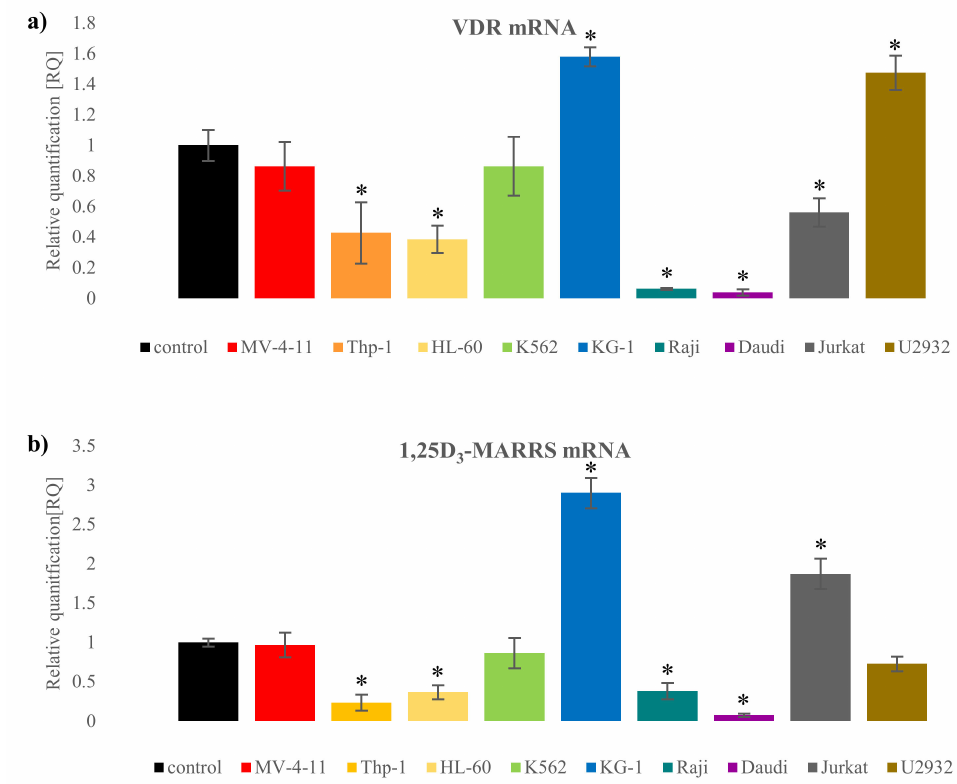
Figure 4. mRNA level of vitamin D binding receptors: classical vitamin D receptor (VDR) ( a ) and 1,25D 3 -MARRS ( b ) in human leukemia and lymphoma cells. The mRNA level was compared to the control level of normal blood cells. *—statistical significance ( p < 0.05) in relation to the control.